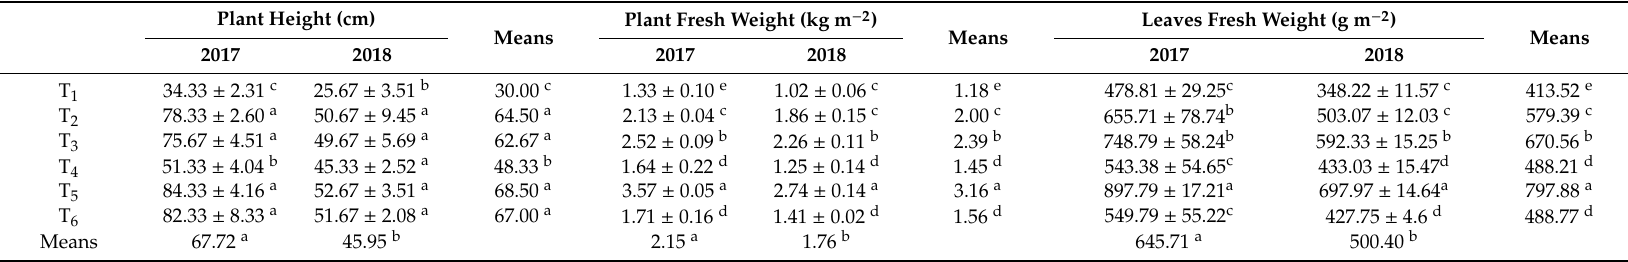
Table 3. E ff ect of organic, inorganic, and biofertilizers on plant growth characteristics (plant height, plant fresh weight, and leaves fresh weight) of Jew’s mallow ( Corchorus olitorius L.) plants.